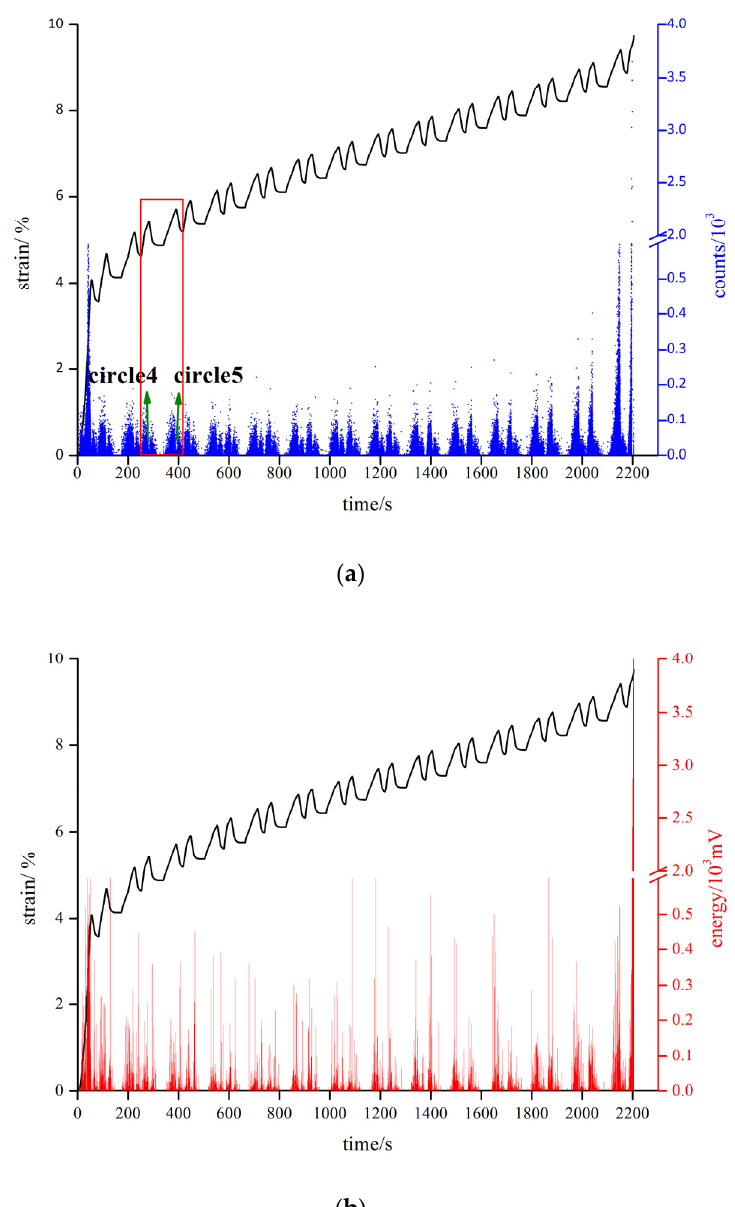
Figure 7. Strain curves and ( a ) AE counts, ( b ) AE energy features for the fatigue tests carried out with a 30 s interval.